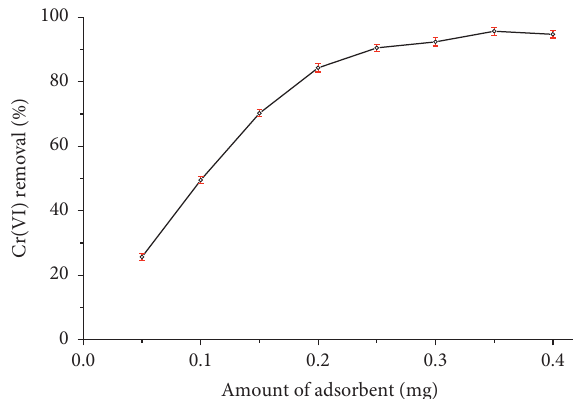
Figure 5: Effect of amount adsorbent on the removal of Cr(VI) using organobentonite. Conditions: C i � 50mg/L, V � 50 mL, T � 20 ° C, pH � 3.0, stirring speed � 200rpm, and contact time � 60min.